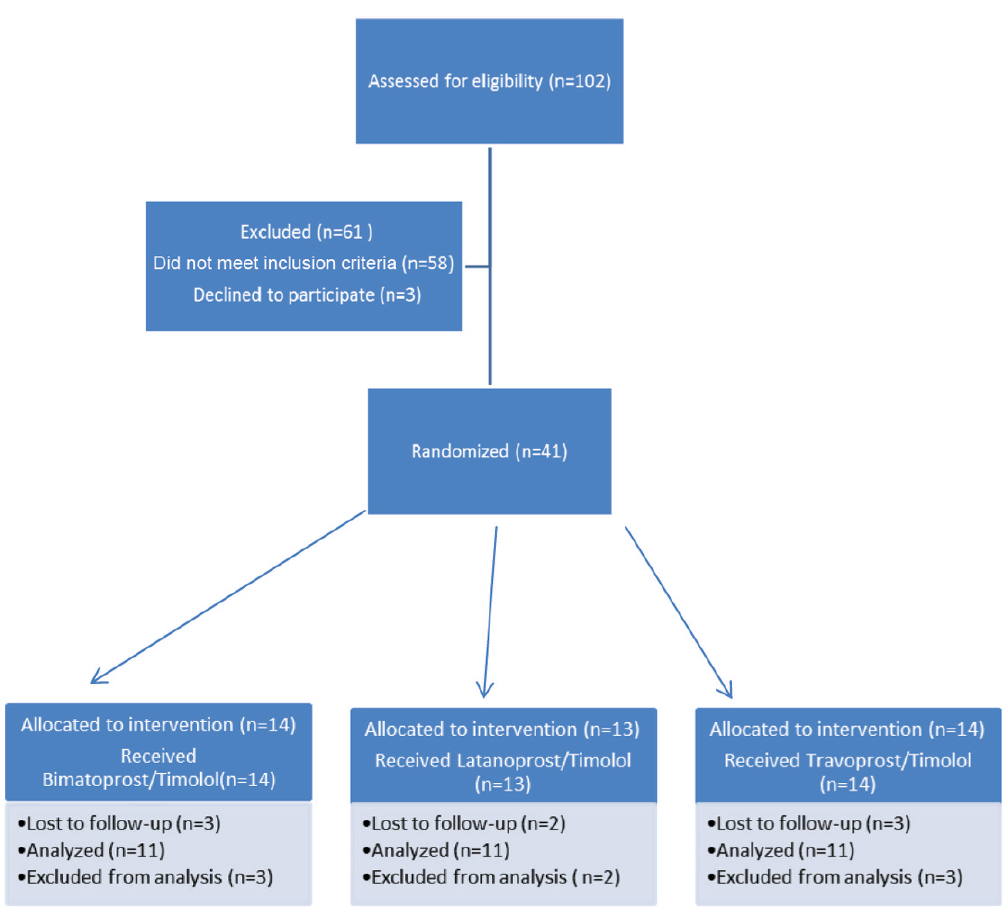
Figure 1 - Flow diagram of the progress through the phases of this parallel, randomized trial of